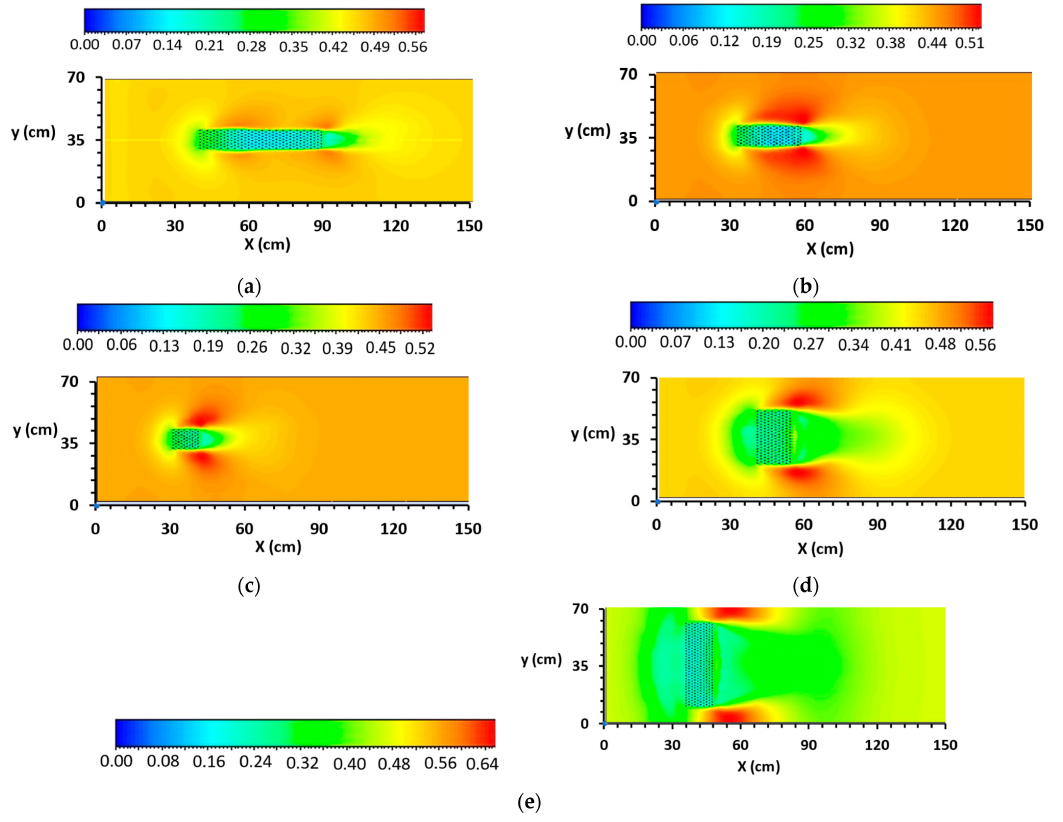
Figure 11. Contour plot distribution of streamwise velocity along the horizontal plane: ( a ) Case 1, ( b ) Case 2, ( c ) Case 3, ( d ) Case 4, ( e ) Case